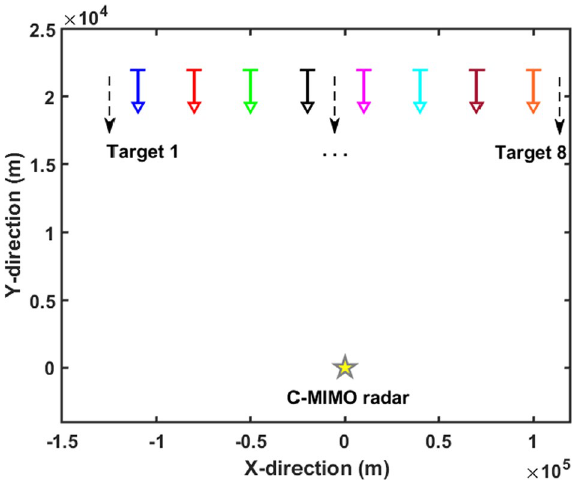
Fig. 2 Joint configuration of the C-MIMO radar and the tracked